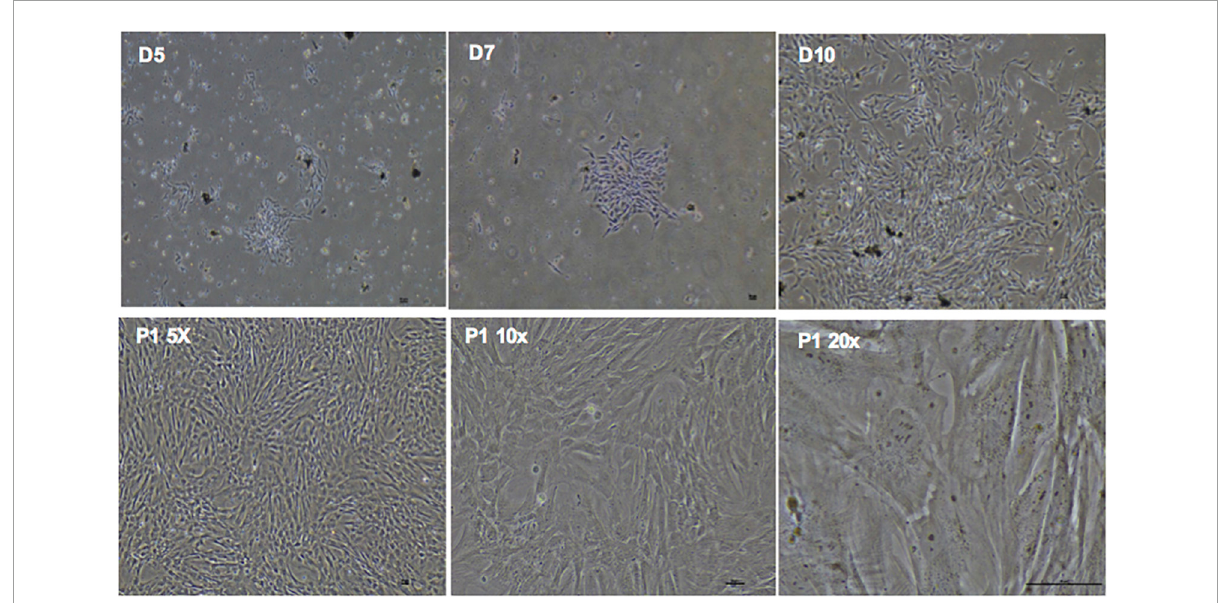
FIGURE1 Primary human dental pulp stem cells (DPSC) show fibroblastic morphology in culture.(D5, D7, D10) Phase contrast microscopy images in the top panel show clonal expansion of DPSC in primary culture with expansion to confluence over time. Bottom panel shows confluent DPSC at increasing magnification in subsequent passages also showing predominantly fibroblastic morphology. Scale bar = 50 µ m.